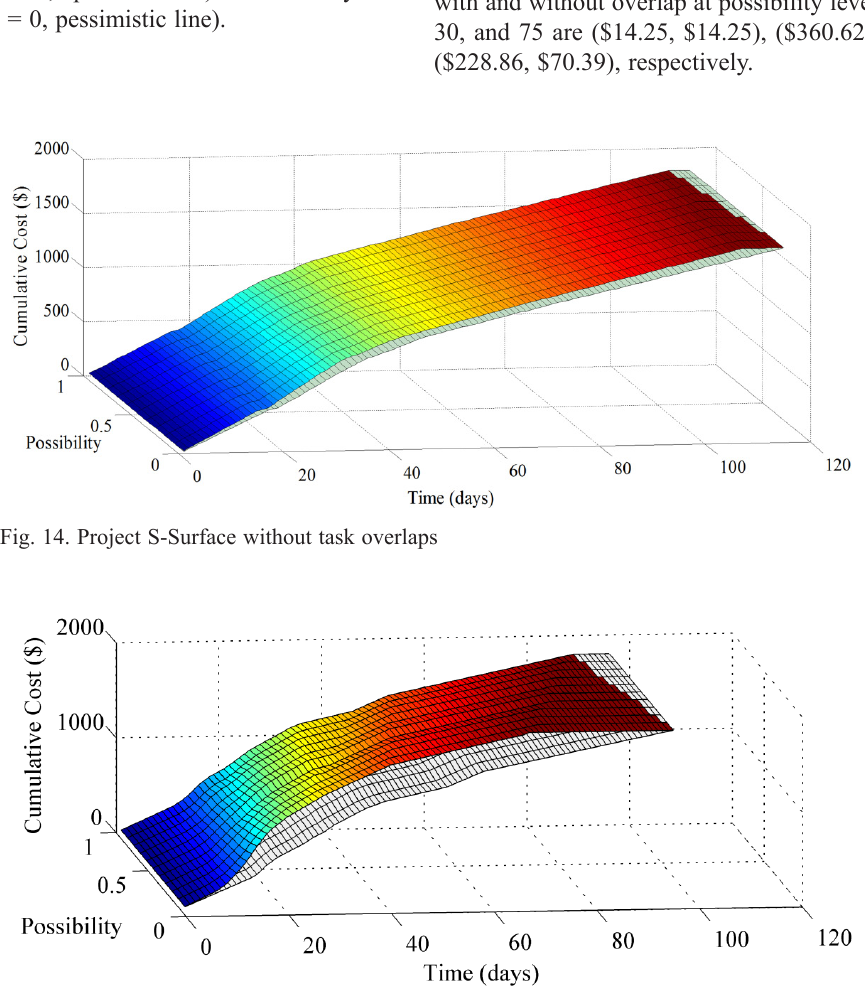
Fig. 15. Project S-Surface with